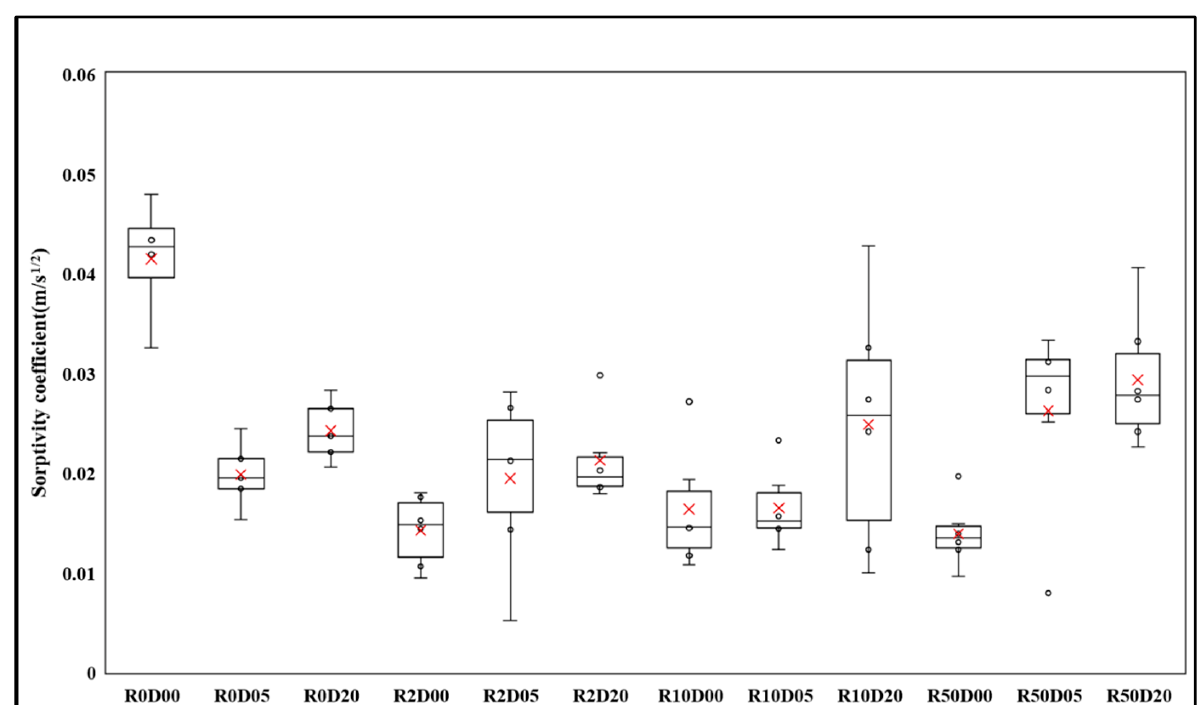
Figure 5. Variation of hydraulic conductivity with ash treatment and rainfall intensity.